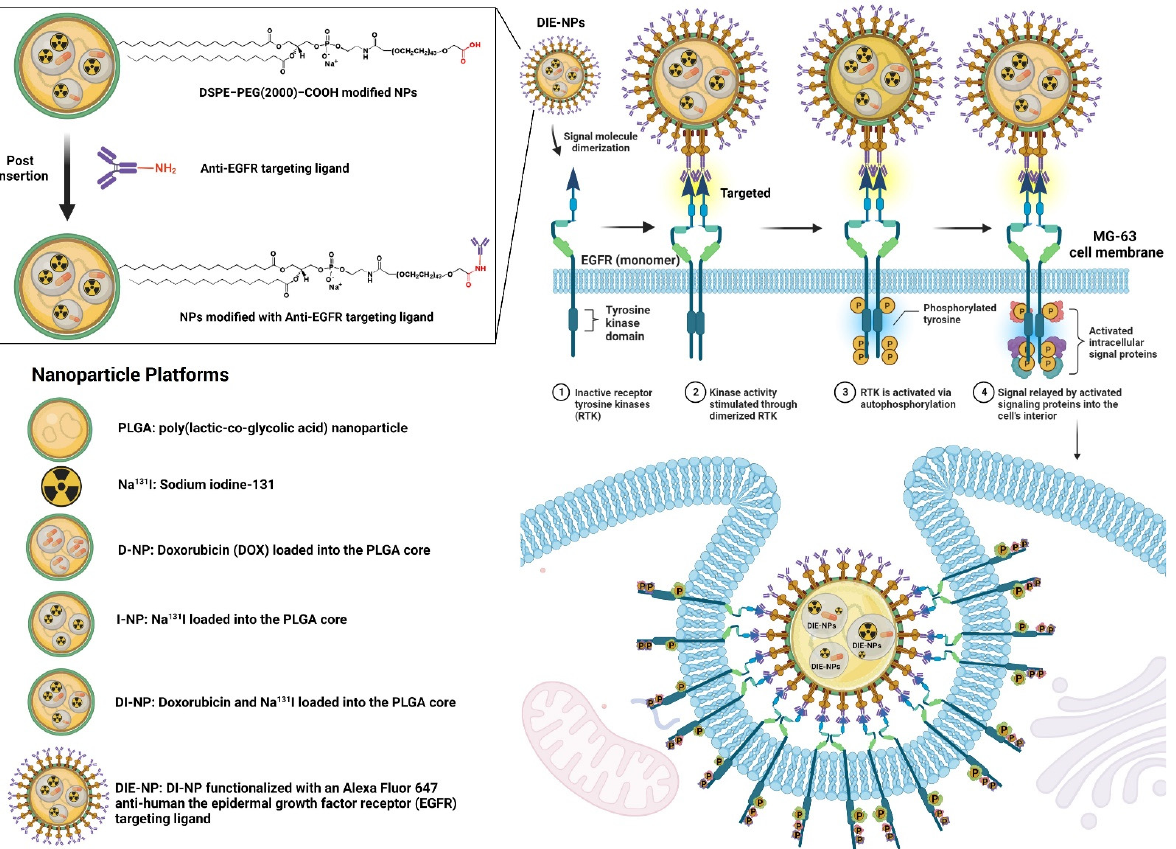
Figure 1. Schematic of DIE-NP nanotherapeutic platform. The fabrication of DSPE − PEG(2000) − COOH modified DIE-NP functionalized with an Alexa Fluor 647 anti-human the epidermal growth factor receptor (EGFR) targeting ligand.